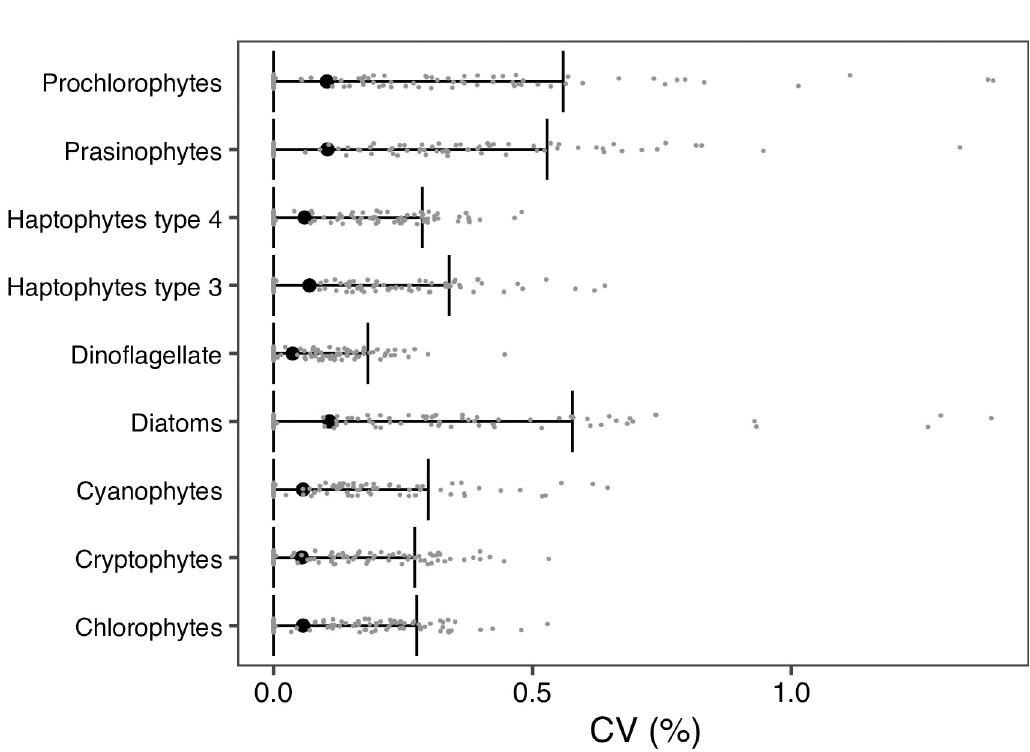
Fig 6. Variations of CV m (%) based on the bootstrap resampling of the reference database. The black circles with whiskers indicated mean values with 95% confident intervals of CV . The small gray point indicated the coefficient of variation (CV) of the m proportion of one target data set calculated based on the bootstrap resampling database from the reference database. Still, the target data was permanently removed ( U 1).